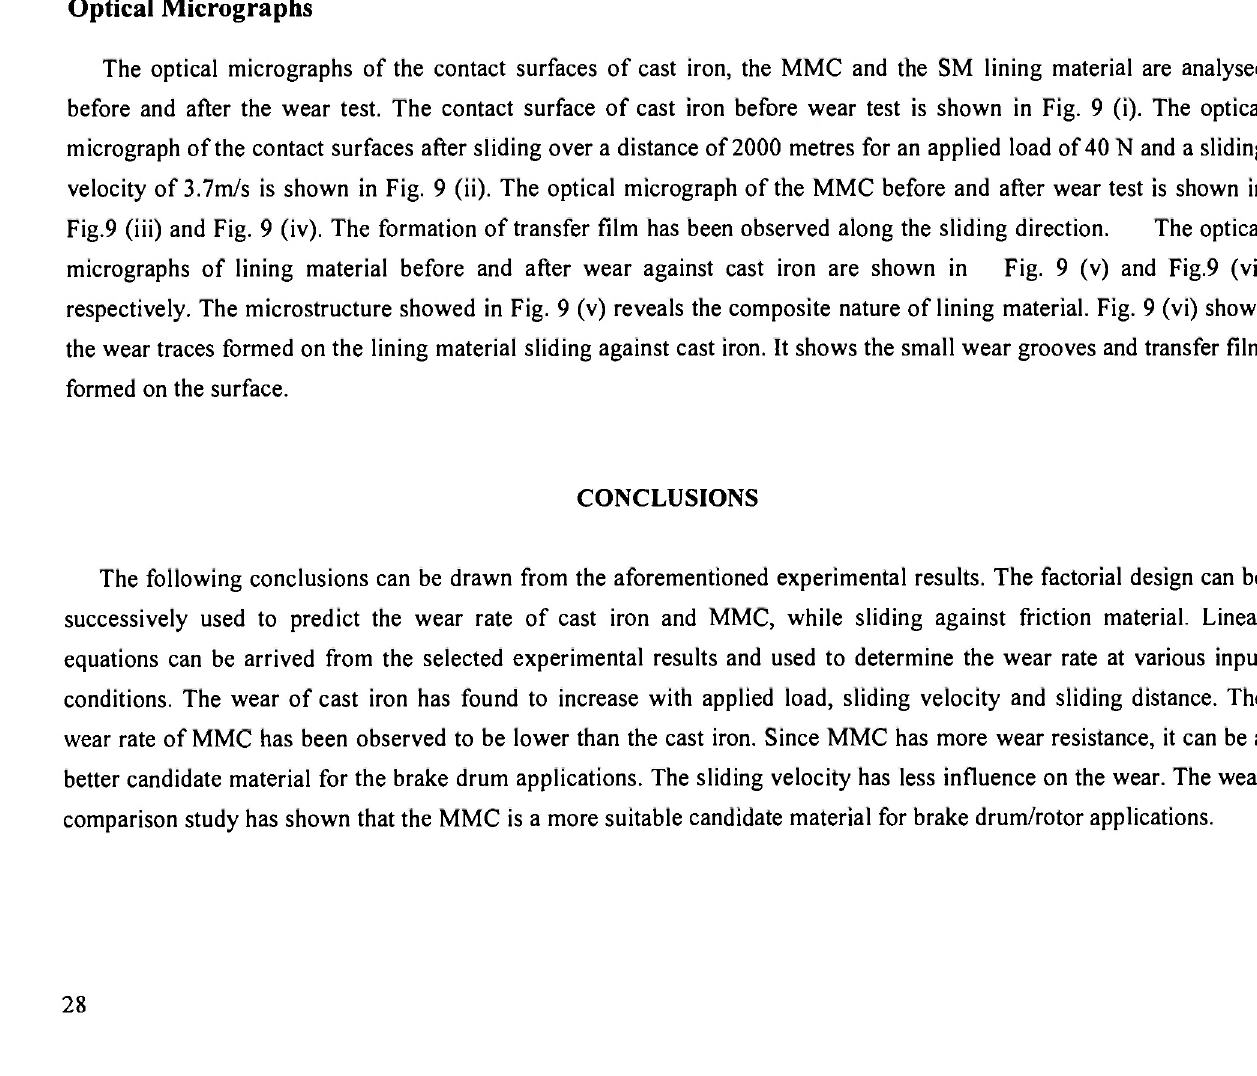
Fig. 8: Variation of wear with sliding distance when load and sliding velocity are at lower level